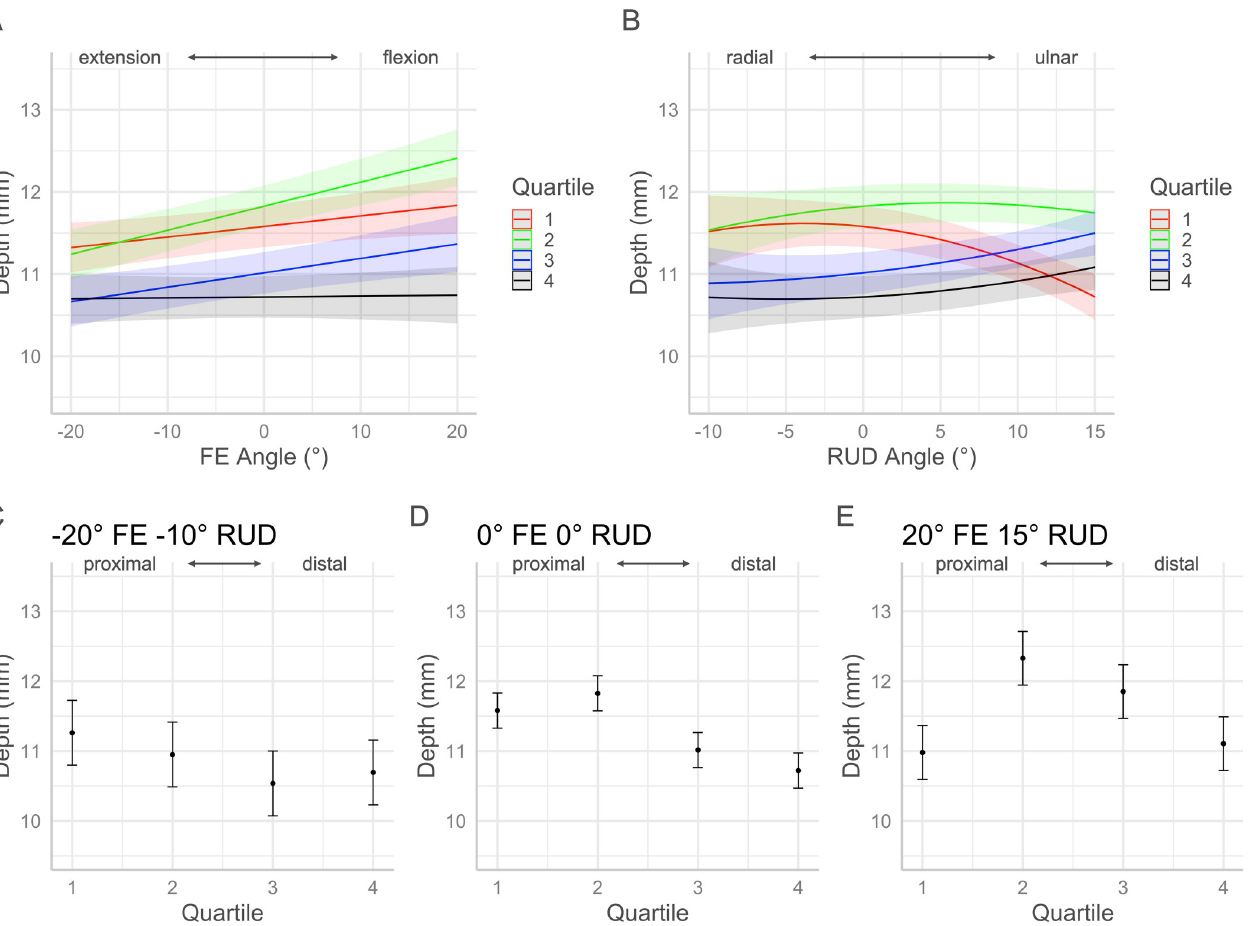
Fig 8. Effects of FE and RUD wrist postures on the mean carpal tunnel depth within each quartile. Panel A shows the effects of varying FE angle with 0˚ RUD. Panel B shows the effect of varying RUD angle with 0˚ FE. Panels C/D/E show the predicted values with 95% confidence intervals for each quartile for an extended radially deviated posture (panel C), a neutral posture (panel D), and a flexed and ulnarly deviated posture (panel E).